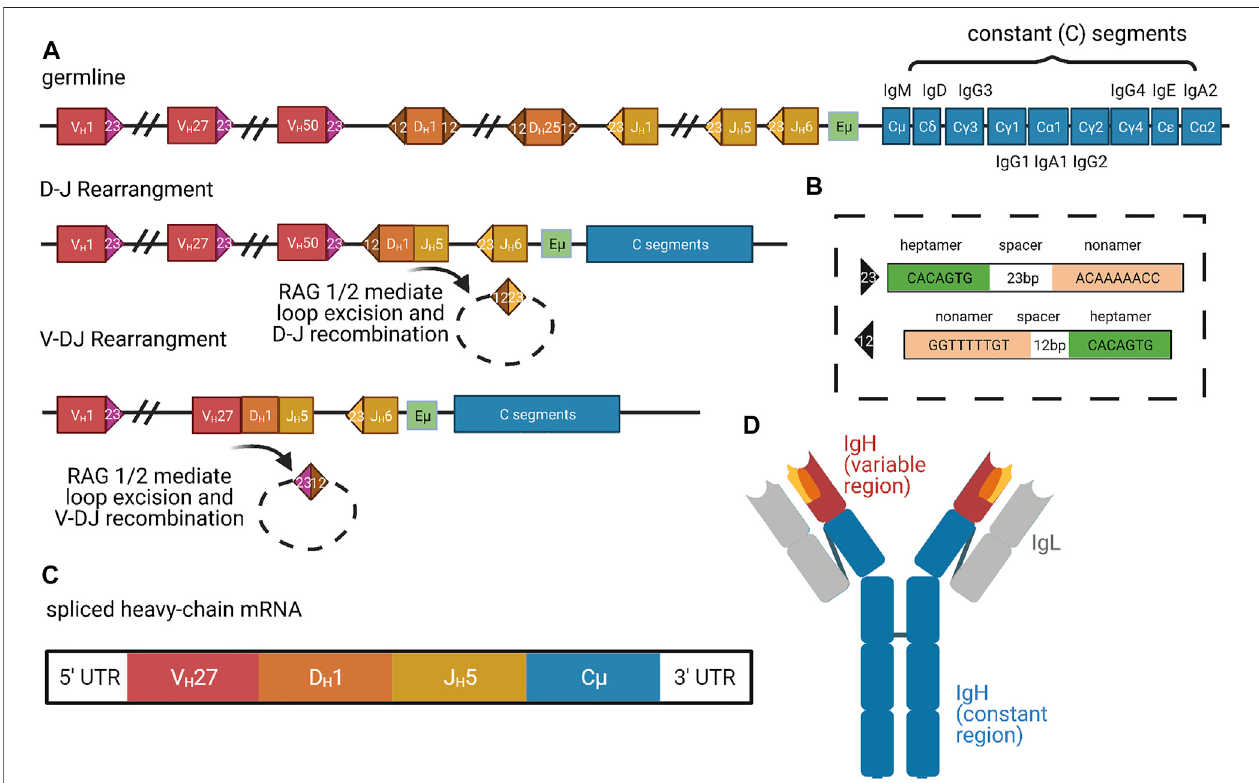
FIGURE 3 | Organization and Expression of Immunoglobulins. (A) Successive organization of the human heavy-chain locus in the germline, after D-J rearrangement,andafterV-DJrearrangement.Thegermlinelocuscontainsroughly50 Vsegments(red),25Dsegments(orange),6 Jsegments(yellow),and9constant segments (blue) (Rodriguez et al., 2020). In the fi rst step of D-J and V-DJ rearrangement, RAG1 and RAG2 complexes bind RSS motifs (colored triangles) (Schatz et al., 1989; Oettinger et al., 1990). (B) The RSS motifs consist of consensus heptamer and nonamer sequences, which are separated by 23 or 12 bp spacers (Ferrier, 2009). (C) In therearrangedDNAlocus(lastlineofpanel (A) ),transcriptiononly proceeds from thepromoterofthemost-proximalVsegmentbecauseitcompetesmost effectively foraccess to thelimiting enhancer E μ and other enhancers (green in (A) ) (Roy et al., 2011). Additionally, intervening J segments aresplicedoutand alternative splicing selects either C μ or C δ constant segments for inclusion, generating IgM or IgD class BCRs, respectively. Upon activation, B cells can switch expression to different downstream